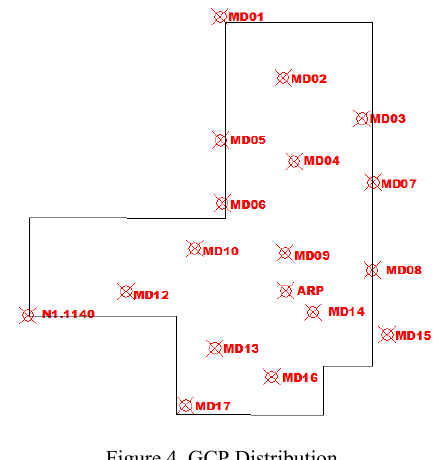
Figure 4. GCP Distribution